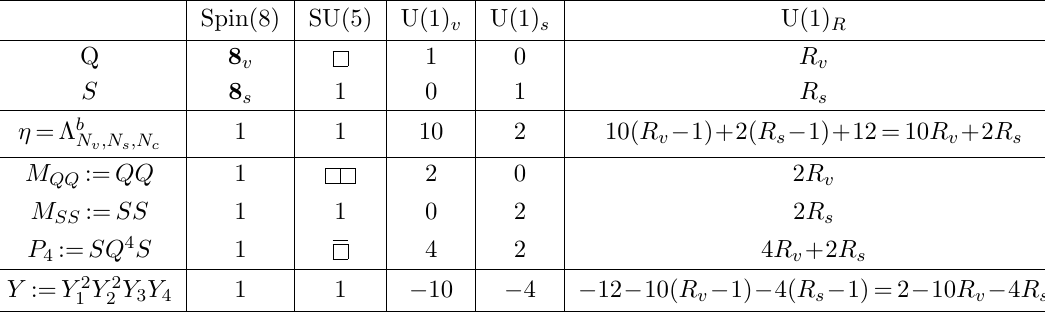
Table 1 . 3d N = 2 Spin(8) theory with ( N v ;N s ;N c ) = (5 ; 1 ;